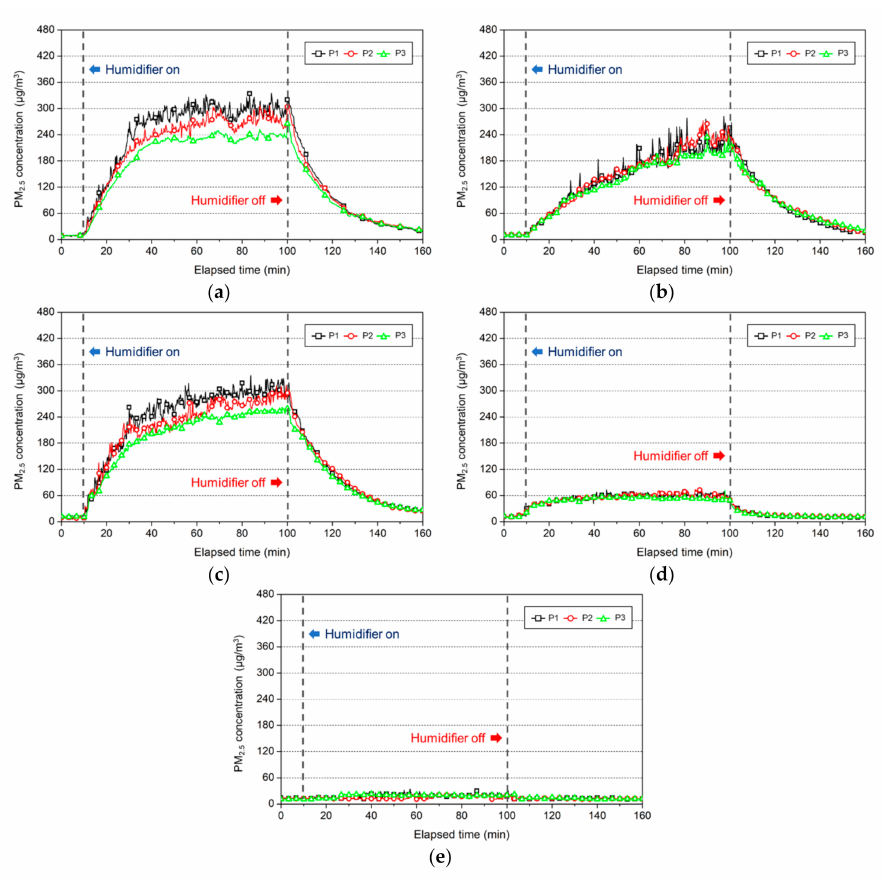
Figure 8. PM 2.5 concentration according to the use of an ultrasonic humidifier for each water type: